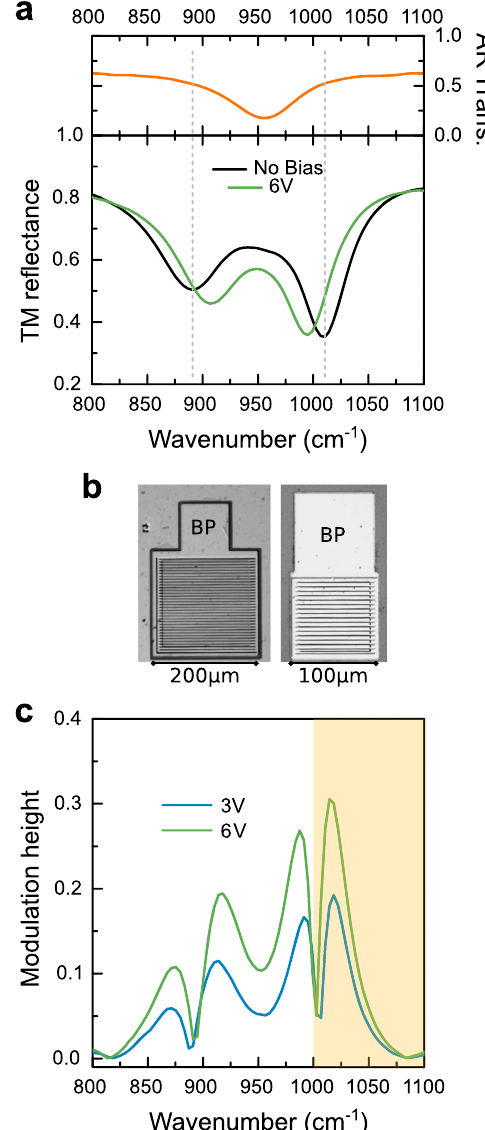
Fig. 2 Active region characterization and device re fl ectance under DC bias. a Top panel: transmission through the bare active region in a typical multipass geometry, at room-temperature: a clear ISB transition at about 955 cm − 1 is measured. Bottom panel: room-temperature re fl ectance spectra under FTIR-coupled microscope of the p = 4.2 μ m sample. The black solid line is the re fl ectance at no bias; the green solid line corresponds to the application of + 6 V. The Rabi-splitting decreases by 25%. b Optical microscope images of the large devices (left; surface 5 × 10 4 μ m 2 ) and of the small ones (right; surface 2 × 10 4 μ m 2 ). The bonding pad (BP in the fi gure) has the same dimensions (100 × 100 μ m 2 )in both samples. (cid:1) (cid:1) (cid:1) (cid:1) c Modulation height extracted from the spectra of panel a (large devices). It (cid:1)(cid:3) (cid:4) (cid:1) (cid:1) (cid:1) (cid:1) (cid:1) (cid:1) (cid:1) ; R NB (cid:1) R B is de fi ned as min R NB (cid:1) R B R and it is plotted in the range 800 – 1100 R NB B cm − 1 for both 3 V (blue solid line) and 6 V (green solid line) biases. The semi-transparent orange region corresponds to the nominal wavelength coverage of our commercial, tunable mid-IR QC laser